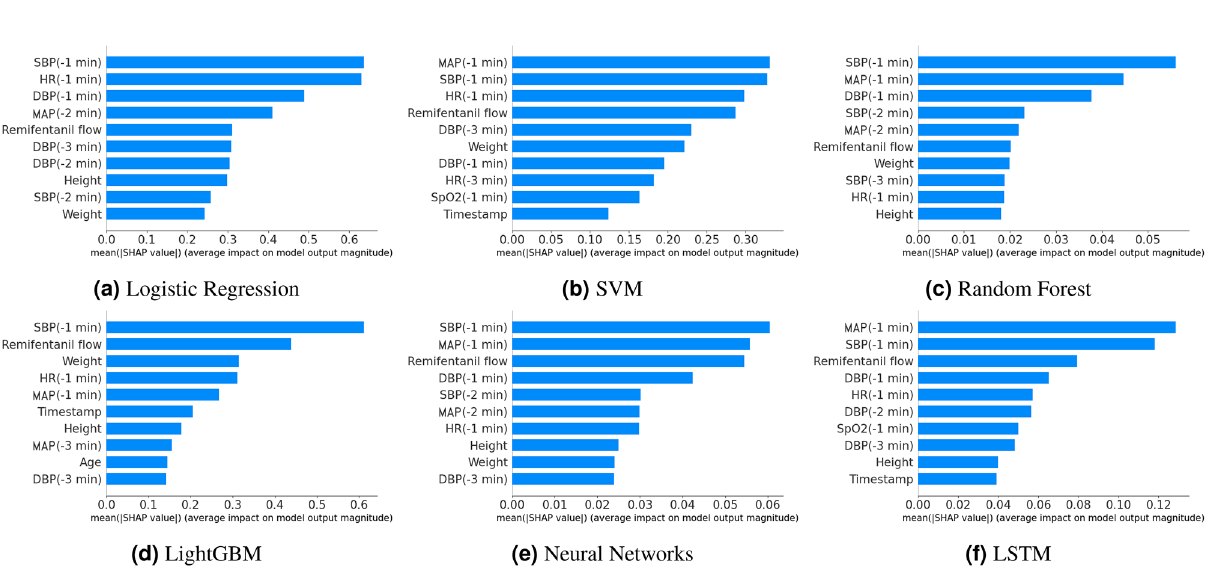
Figure 2. Top 10 important features calculated according to mean absolute SHAP values. SBP, MAP, HR, remifentanil flow, and patient weight immediately before prediction are relatively important features for all